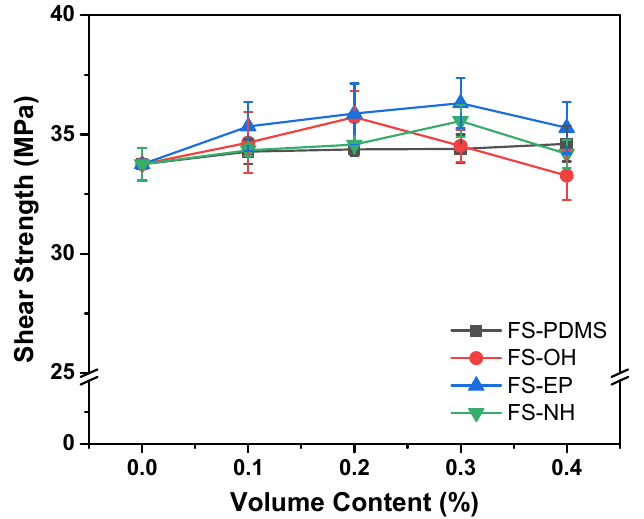
Figure 8. Lap shear test results of epoxy adhesives with different silica nanoparticles and contents. The fracture surfaces of FS-PDMS-modified epoxy adhesives after the lap shear test are given in Figure S1 in the supplementary information. They showcase clean surfaces of test strips, which indicate interfacial failure. Since the interfacial adhesion is dominated by the wetting and specific interaction of an adhesive, the viscosity of silica-modified epoxy adhesives is measured. As shown in Figure 9, at 0.3 vol% silica nanoparticles, the viscosities of epoxy adhesives are 121.575 Pa · s with FS-PDMS and 91.981 Pa · s with FS-EP, which are higher than 71.585 Pa · s for pristine adhesive. Consequently, the low interfacial adhesion strength of PS-PDMS-modified epoxy adhesives is believed to be due to the increased viscosity.